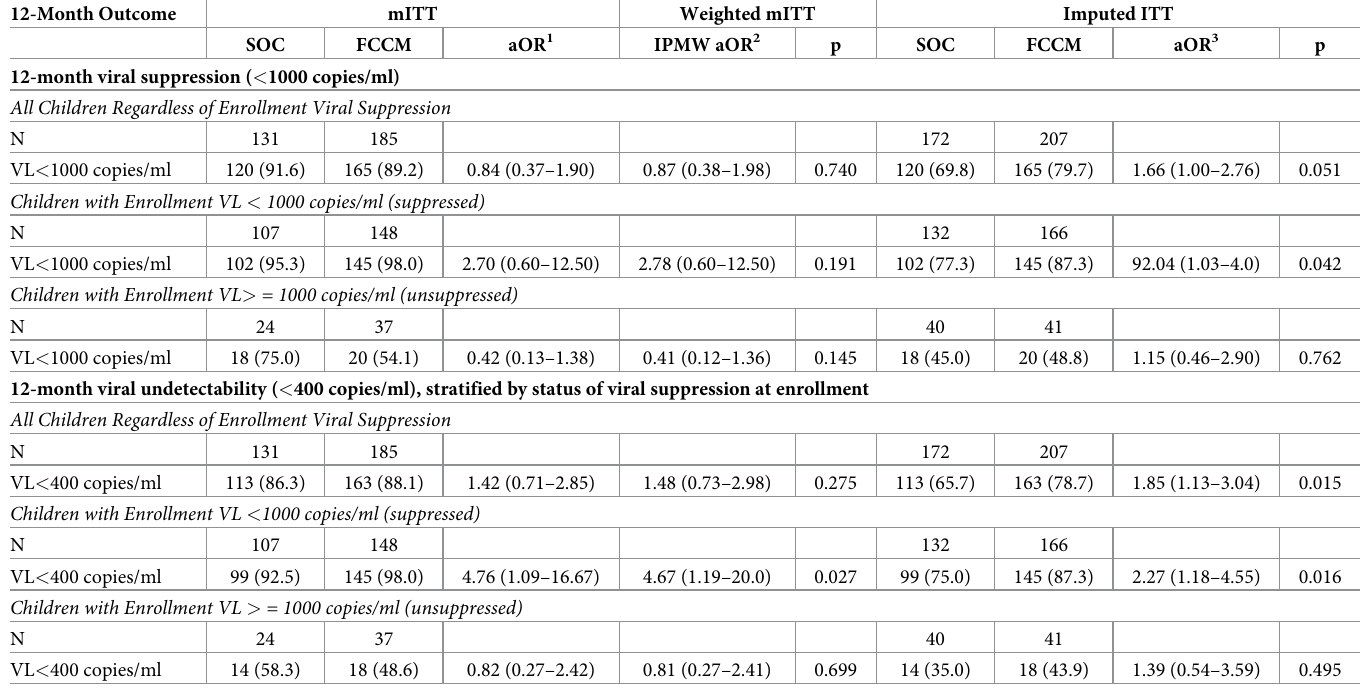
Table 3. Effect of FCCM intervention on virologic suppression and undetectability at 12 months compared to standard of care, all children and stratified by whether there is viral suppression at enrollment. 12-Month Outcome mITT Weighted mITT Imputed ITT